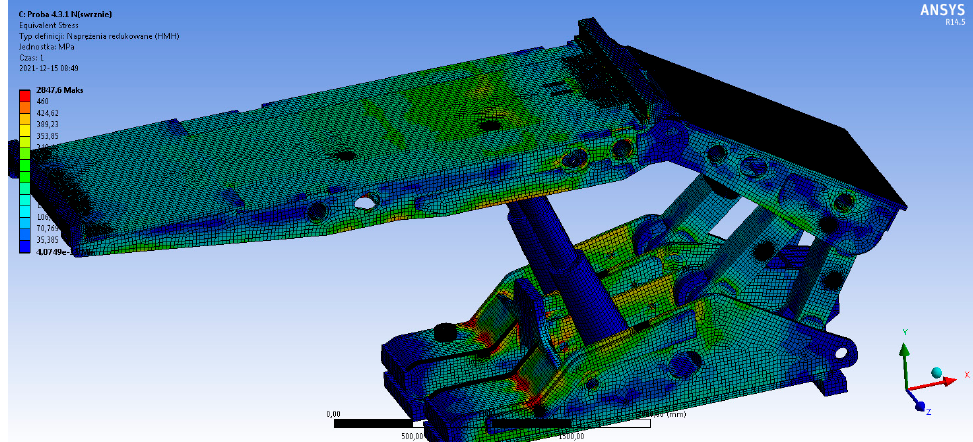
Figure 7. Stress analysis on a finite element grid.